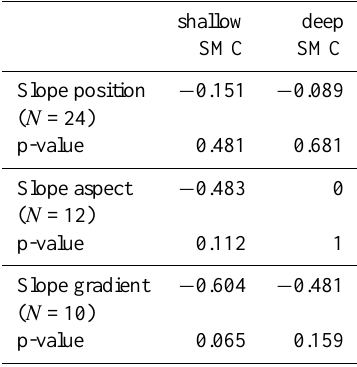
Table 5. Correlation analysis of SMC and topographical factors.